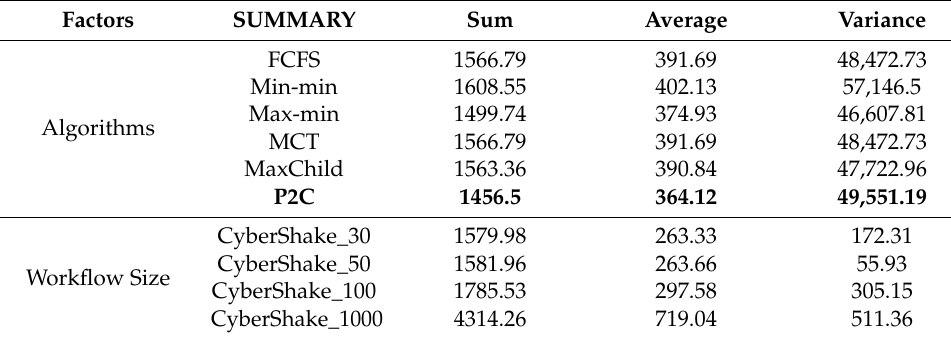
Table 6. Two way ANOVA Summary results for CyberShake Workflow.